Question: What visual encoding does this figure use to show its data?
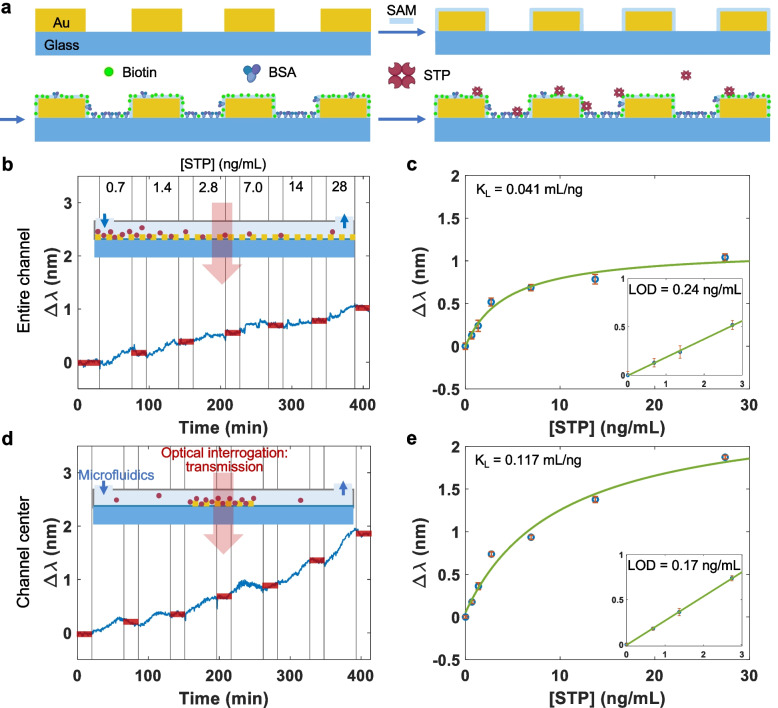
Answer: bar